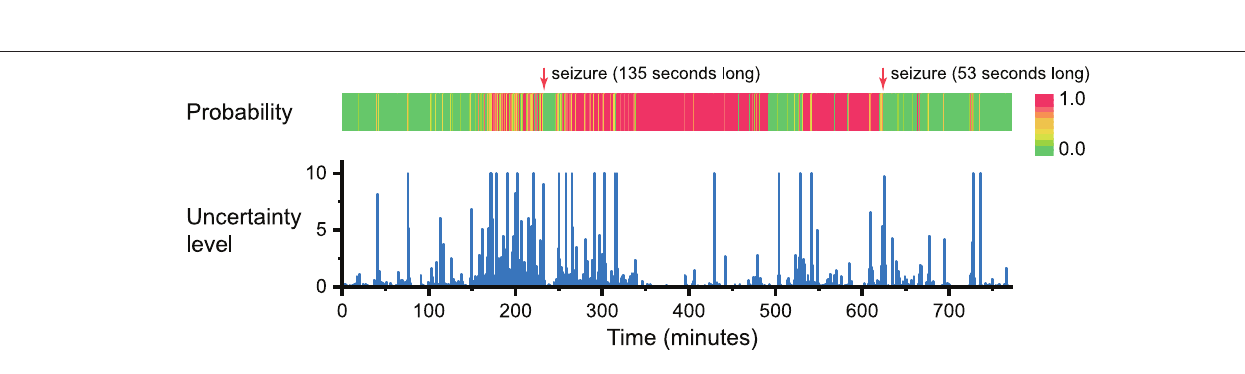
Frontiers in Neurology |